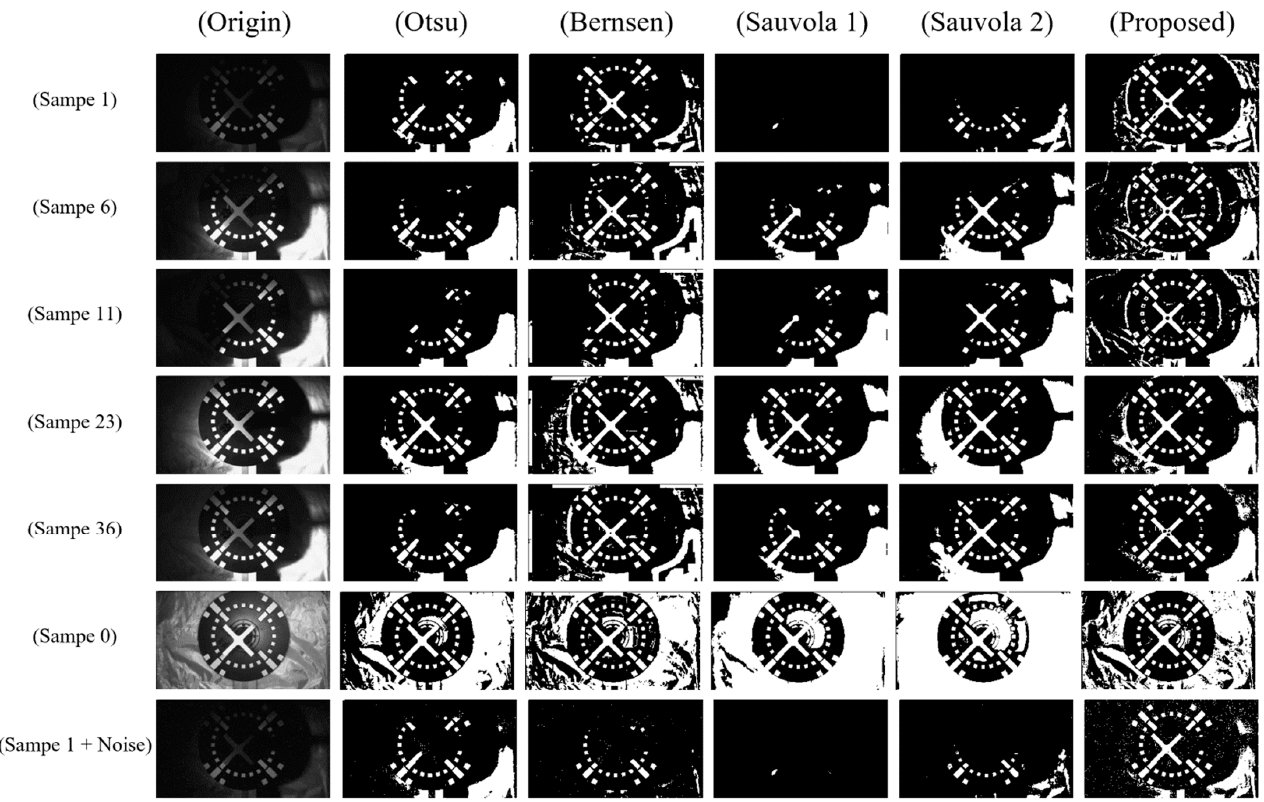
Figure 15. Comparison of three algorithms for binarization.